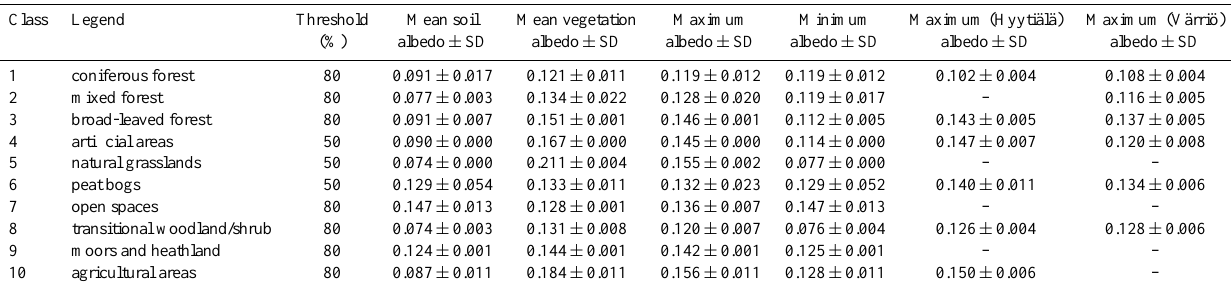
Table B2. Derived soil albedo and vegetation albedo values with standard deviations for the land cover classes in the FNFI maps and the threshold used for each land cover class; the minimum and maximum background albedo values (with standard deviations) in the yearly cycle calculated based on the derived soil and vegetable albedo values are also shown, as well as the summertime albedo values (i.e. maximum background albedo values) of the corresponding land cover classes observed at two Finnish stations (Hyytiälä, Värriö) in Kuusinen et al.